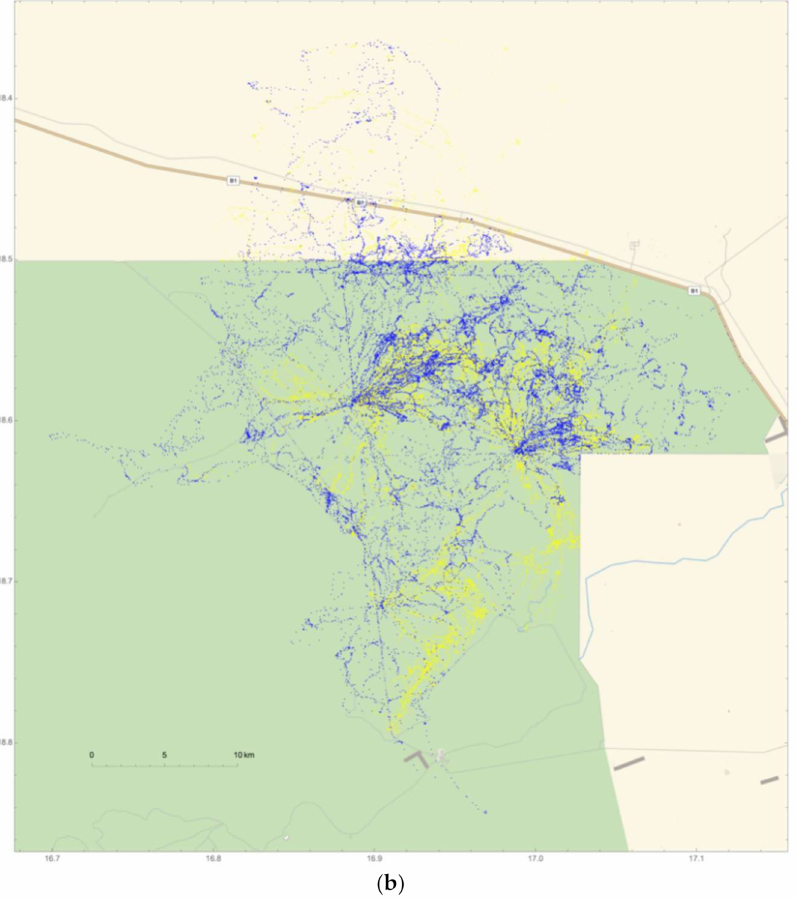
Figure 6. Two collared adult males (#264 and #267) traveled beyond park boundaries and into human-modified landscapes (HMLs) north of ENP during both wet and dry seasons. The edge of the green line in ( a , b ) represents the park’s boundary that abuts HMLs, shown in tan. Everything north of the Omuthiya road (brown line and labeled B1 on Figure 6b) is agricultural land where crop-raiding has been known to occur; ( a ) elephant #264 traveled across a large span of the northern HML region on a total of 166 days, while ( b ) #267 was observed in the northeastern HML region on a total of 76